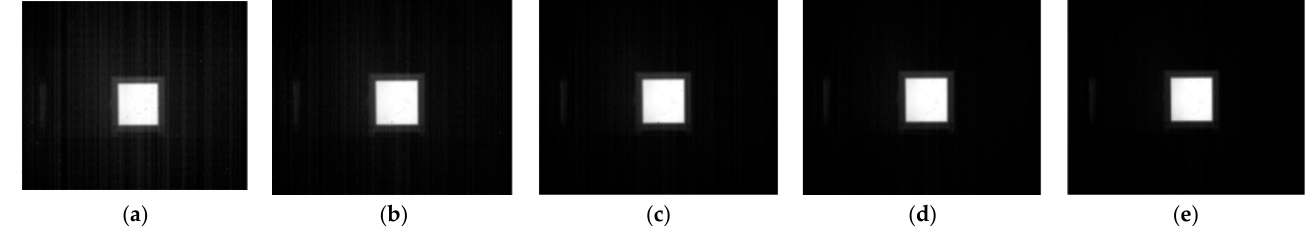
8 of 12 Figure 5. Fitted straight line with the least square method.